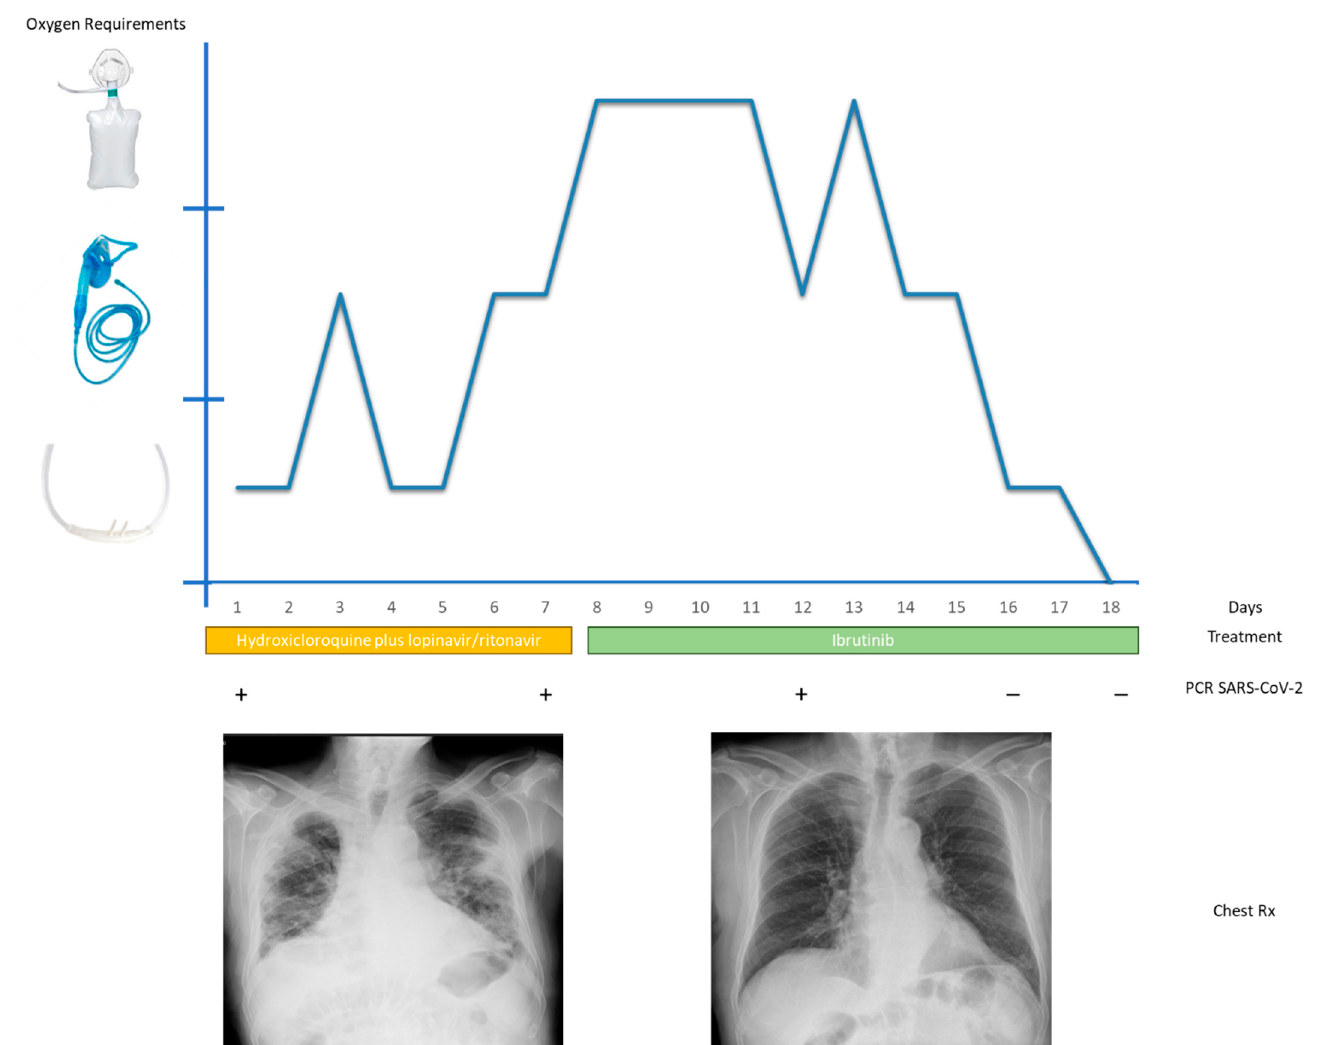
Figure 1. Patient’s clinical behavior according Rx evolution and oxygen requirements.